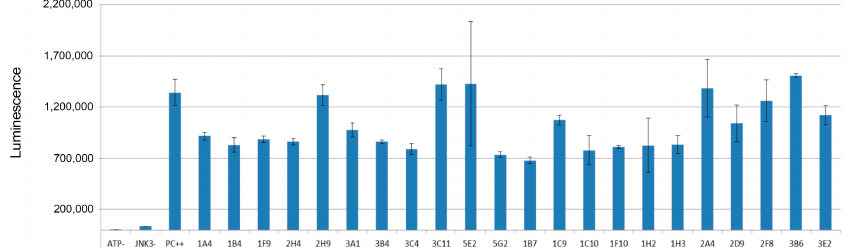
Figure 2. In vitro kinase assay and the inhibitory effects of selected fragments. PC++ stands for the positive control without any fragment molecules. The experiments were duplicated, and the errors were indicated.